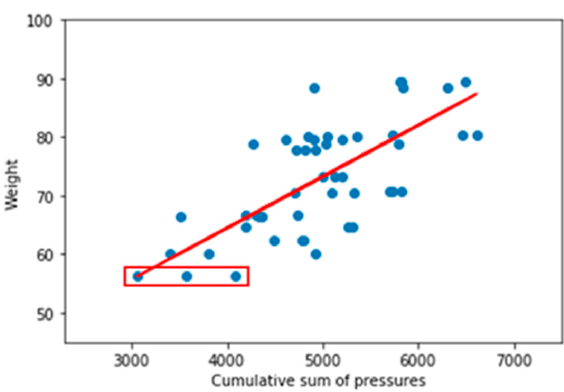
Figure 4. The relationship between body weight and cumulative sum of pressures.